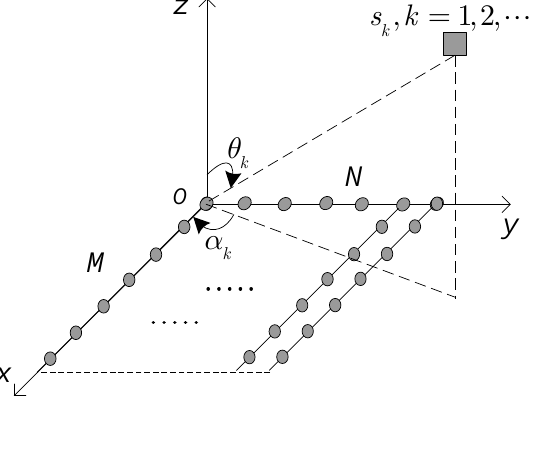
Figure 1. The geometry model of a